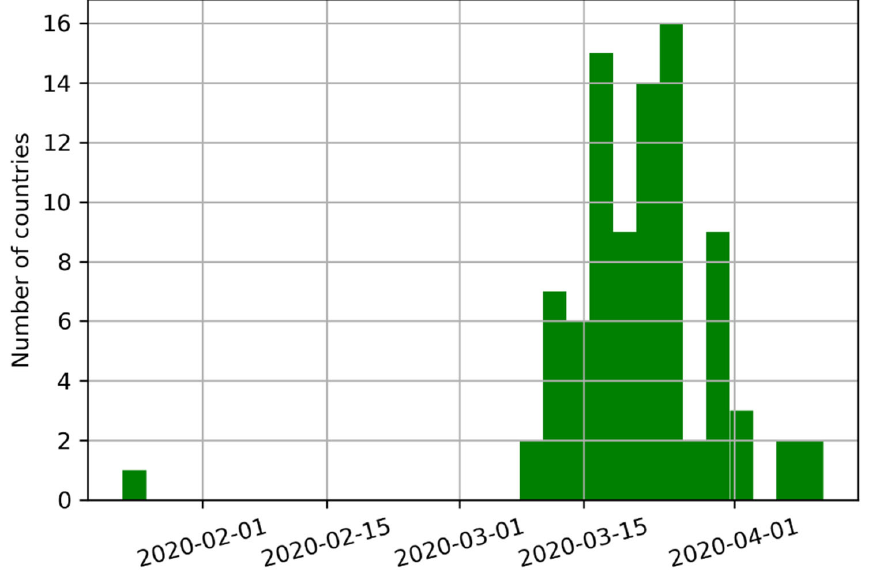
Figure 2. Eighty-eight countries have instituted controls, covering a combined 6.17 billion inhabitants (approx. 79.09). The median start date was 22 March 2020. California was the first state in the U.S. to impose a stay-at-home order on 19 March